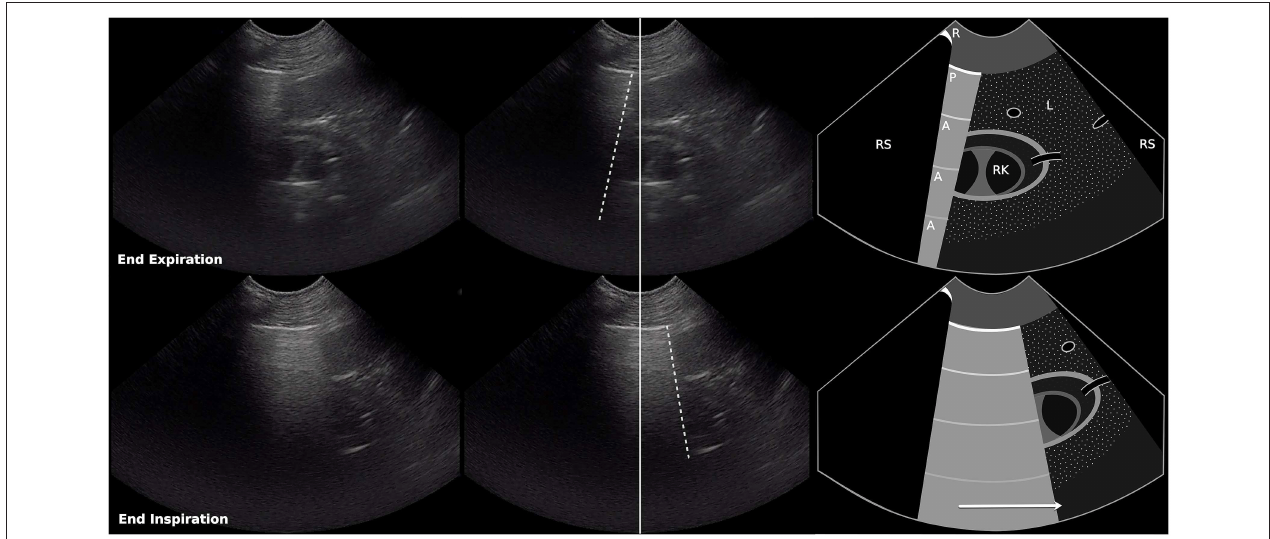
FIGURE 1 | Still images and schematic of a normal curtain sign at end expiration (top row) and end inspiration (bottom row). The ultrasound probe was positioned over the right paralumbar region at the level of the right kidney, over the liver, between the 11th and 12th intercostal spaces, and incorporates the air/soft tissue interface between the abdomen and the thorax which appears as a vertical edge (curtain sign). During inspiration, the vertical edge of the curtain sign and the abdominal contents move caudally at a similar rate. Dashed lines, vertical edge (air/soft tissue interface); Solid line, center of image; R, rib; RS, rib shadow; P, pleural line; A, A line; L, liver; RK, right kidney. Arrow shows direction of movement of the vertical edge during inspiration (also see Video S1